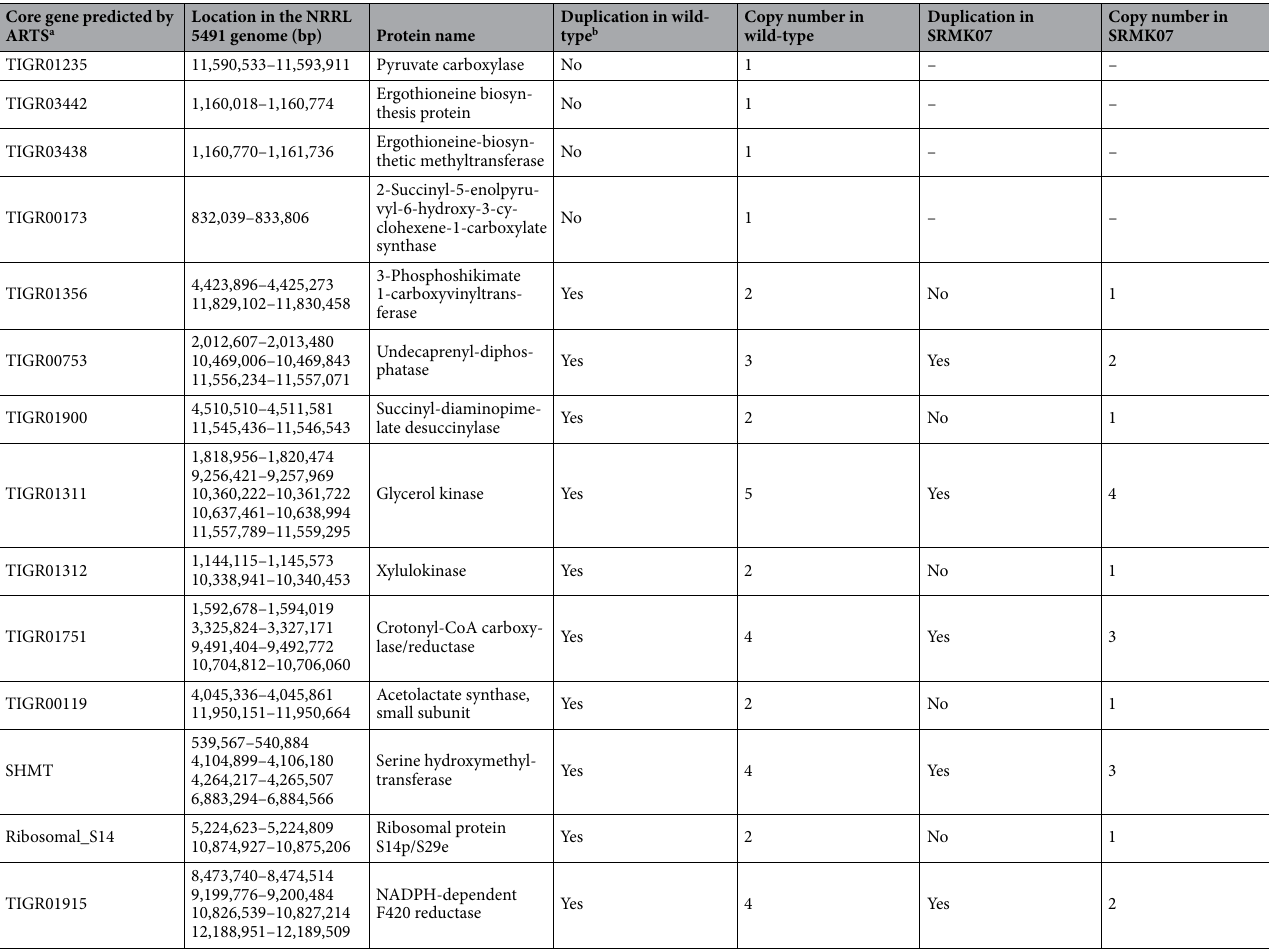
Table 2. Deleted core genes in the SRMK07 strain’s genome. a Identifiers (IDs) of the detected core genes were obtained from ARTS, which are mostly TIGRFAM IDs 32 . b ‘Duplication’ indicates the presence of a gene with a greater copy number than the average copy number of this gene present in other